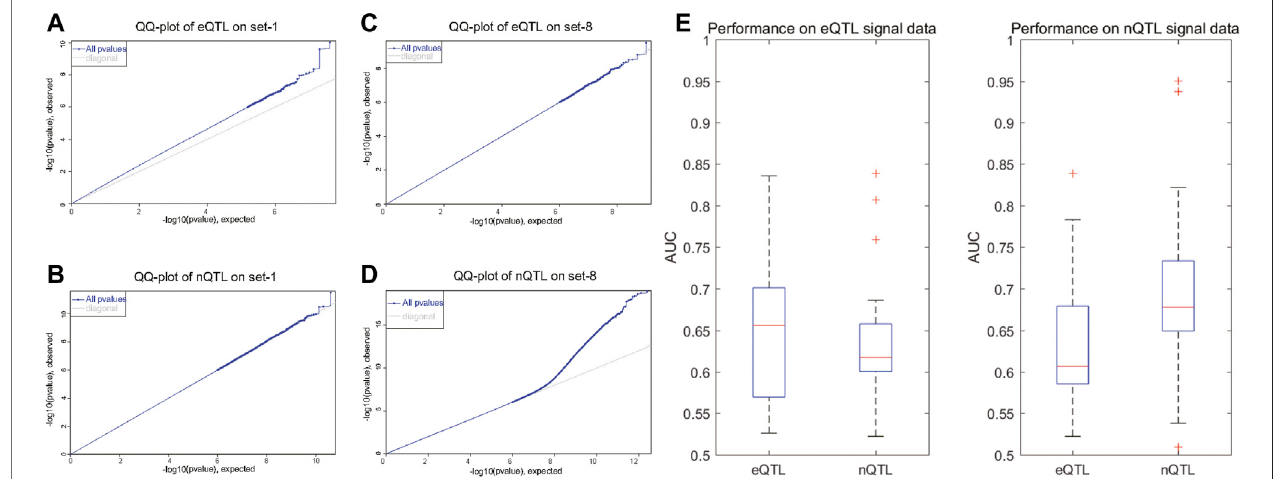
FIGURE 2 | Comparison of eQTL and nQTL identi fi cation on synthetic datasets based on expression traits and network traits. (A , B) QQ-plot of eQTL and nQTL, respectively, on a simulated data with preset expression traits. (C , D) QQ-plot of eQTL and nQTL, respectively, on a simulated data with preset edge traits. (E) AUC measurementcomparisonbetweennQTLandeQTLidenti fi cationsonmultipledatasetswithpresetexpressiontraits. (F) AUCmeasurementcomparisonbetweennQTL and eQTL identi fi cations on multiple datasets with preset edge traits.